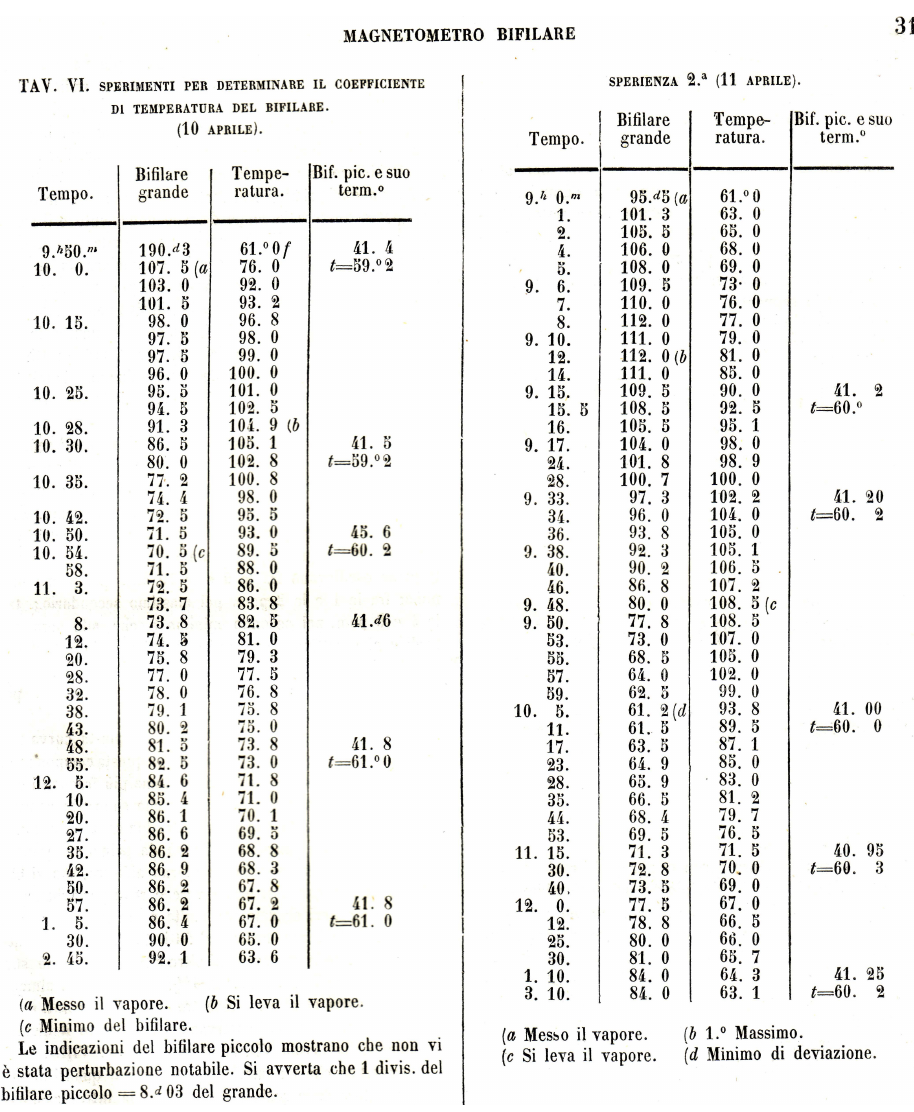
Figure 10. Summary of experiments for determining temperature coe ffi cients of bifilar magnetometers (Secchi, 1861). The results were obtained on 10 (left) and 11 (right) April 1859. The tables show time (1st column), data of the large declinometer in divisions of scale (2nd), its temperature (3rd) and the reading of the portable bifilar with its temperature t